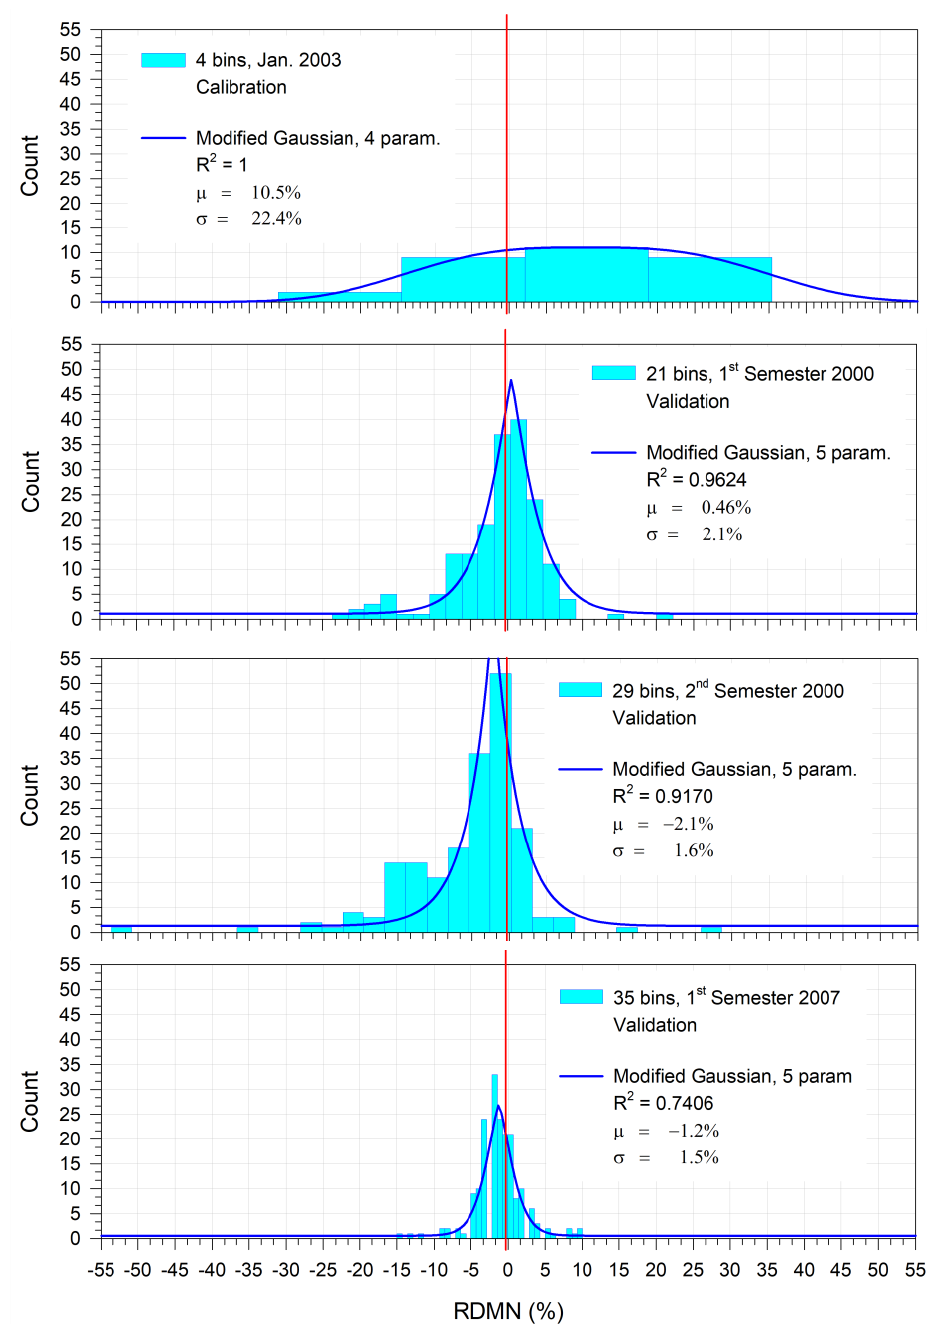
Figure 11. RDMN histograms based on the Freedman–Diaconis rule for each selected time period; µ is the distribution mean; σ is the standard deviation of the selected distribution.